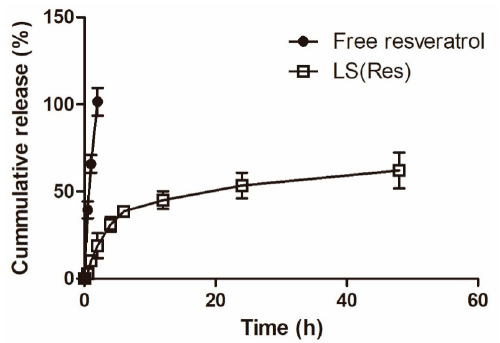
Figure5. PercentageofcumulativereleaseoffreeresveratrolandLS(Res)inPBS(pH7.4). Mean ± S.E.M, Figure 5. Percentage of cumulative release of free resveratrol and LS (Res) in PBS (pH 7.4). Mean ± S.E.M, n = 3. n =